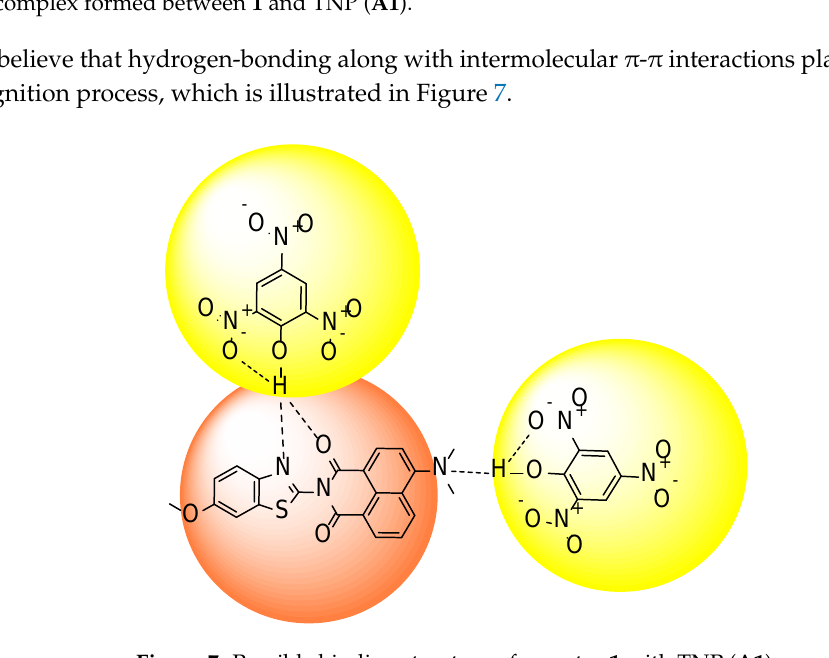
Figure 7. Possible binding structure of receptor 1 with TNP (A1) .